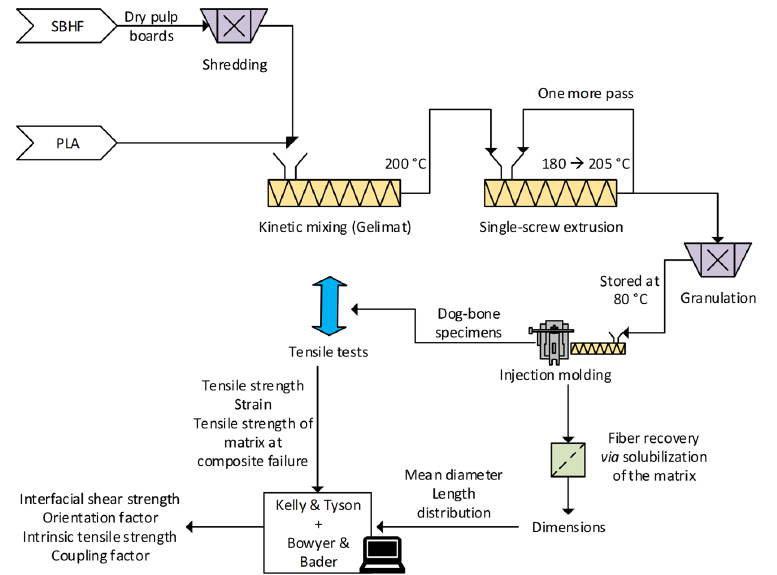
Figure 1. Depiction of the experimental procedure, schematizing preparation, testing and microme- chanical